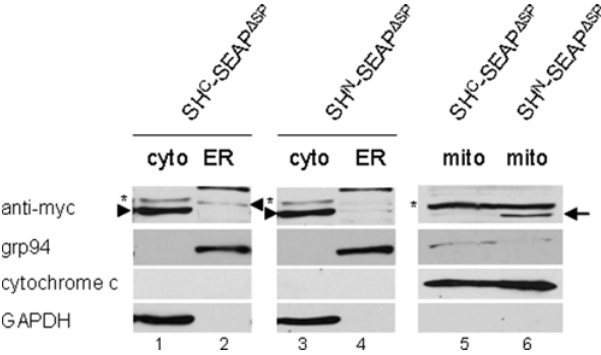
Figure 4. Detection of SH N -SEAP D SP in mitochondria. Mitochon- dria were isolated from HEK 293T transfected with either SH N -SEAP D SP or SH C -SEAP D SP , and Western blots were prepared with cytosolic (cyto), ER and mitochondrial (mito) fractions. SEAP fusion proteins were probed with antibody against the myc-tag (anti-myc). Marker proteins were grp94 for ER, cytochrome c for mitochondrial, and GAPDH for cytosolic fractions. Only SEAP fusion protein containing the N-domain of shrew-1’s SP (SH N -SEAP D SP ) was clearly detectable in the mitochon- drial fraction (lane 6, arrow). Asterisks on the left indicate unspecific bands. Arrowheads mark the positions of SEAP fusion proteins in the cytosolic and ER fractions.